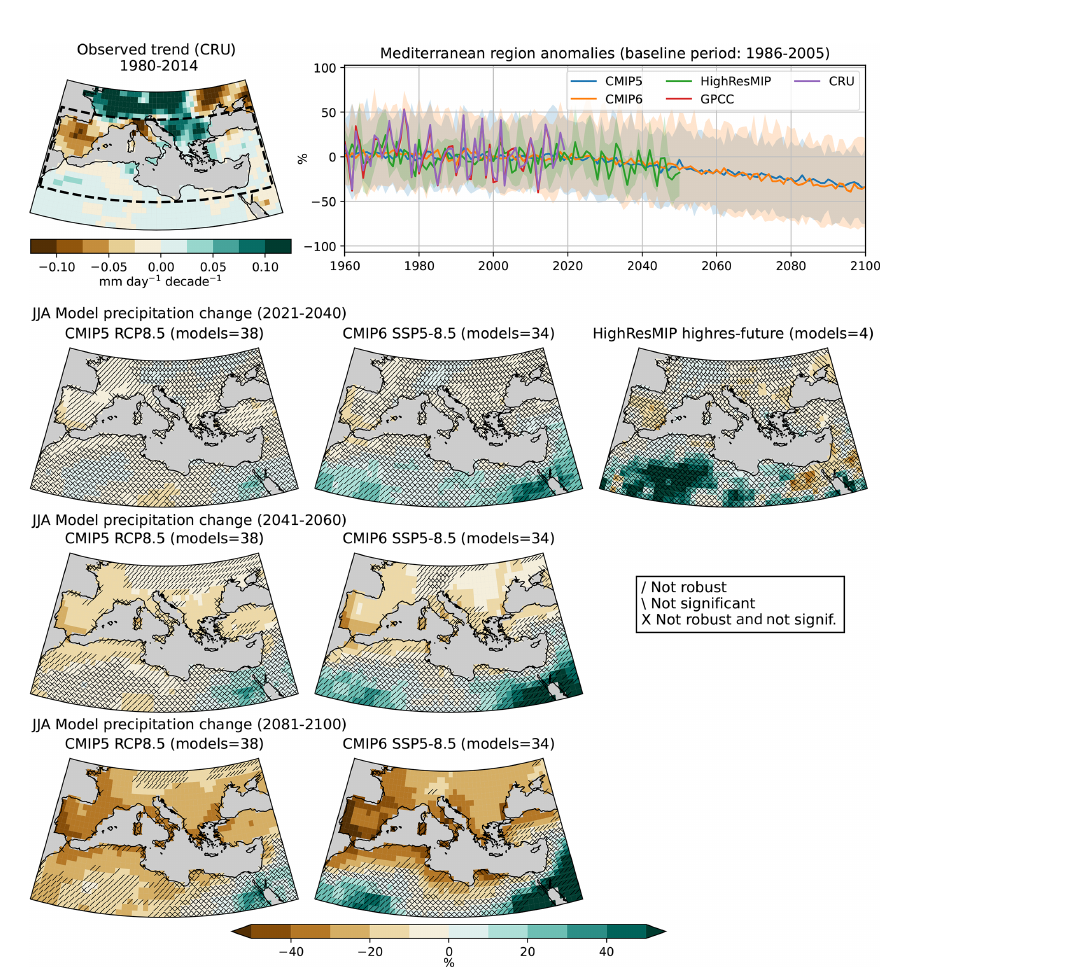
Figure 6. Same as Fig. 5 for JJA precipitation and showing CRU in the top left panel.